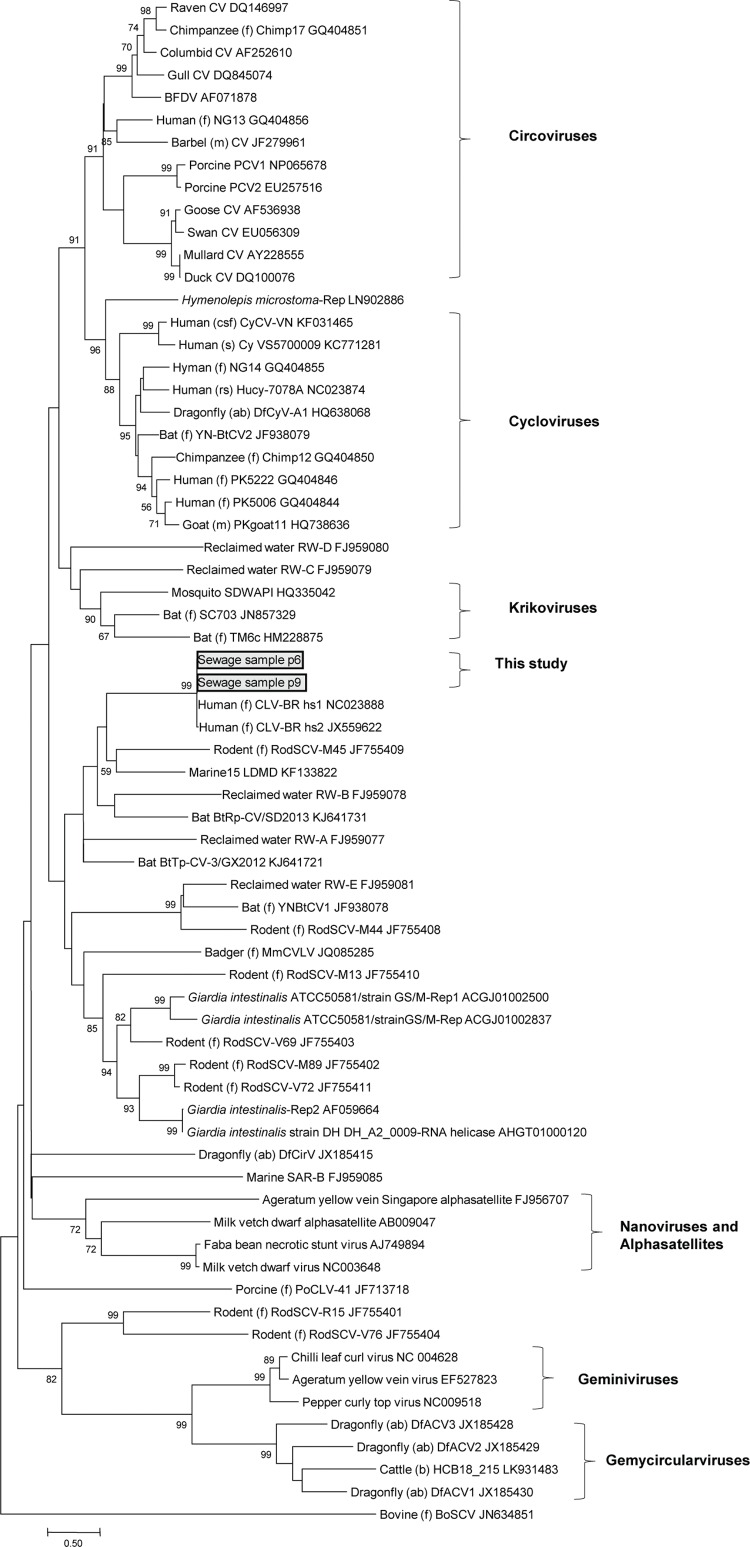
: maximum-likelihood phylogenetic analysis based on the replication
initiator protein (Rep) sequences of circo-like virus-Brazil (CLV-BR),
representative members of the Circoviridae,
Geminiviridae and Nanoviridae families,
alphasatellites, parasites, the proposed new genera of cycloviruses,
gemycircularviruses and krikoviruses, and still unassigned novel CRESS-DNA
viruses. The complete Rep sequences used as references were retrieved from
GenBank. The GenBank accession number of each sequence is shown. Only bootstrap
values > 50% are shown. Bar = 0.5 aa substitutions per site. Sequences
identified in feces (f), meat (m), serum (s), cerebrospinal fluid (csf),
abdominal samples (ab) and respiratory secretions (rs) are specified.